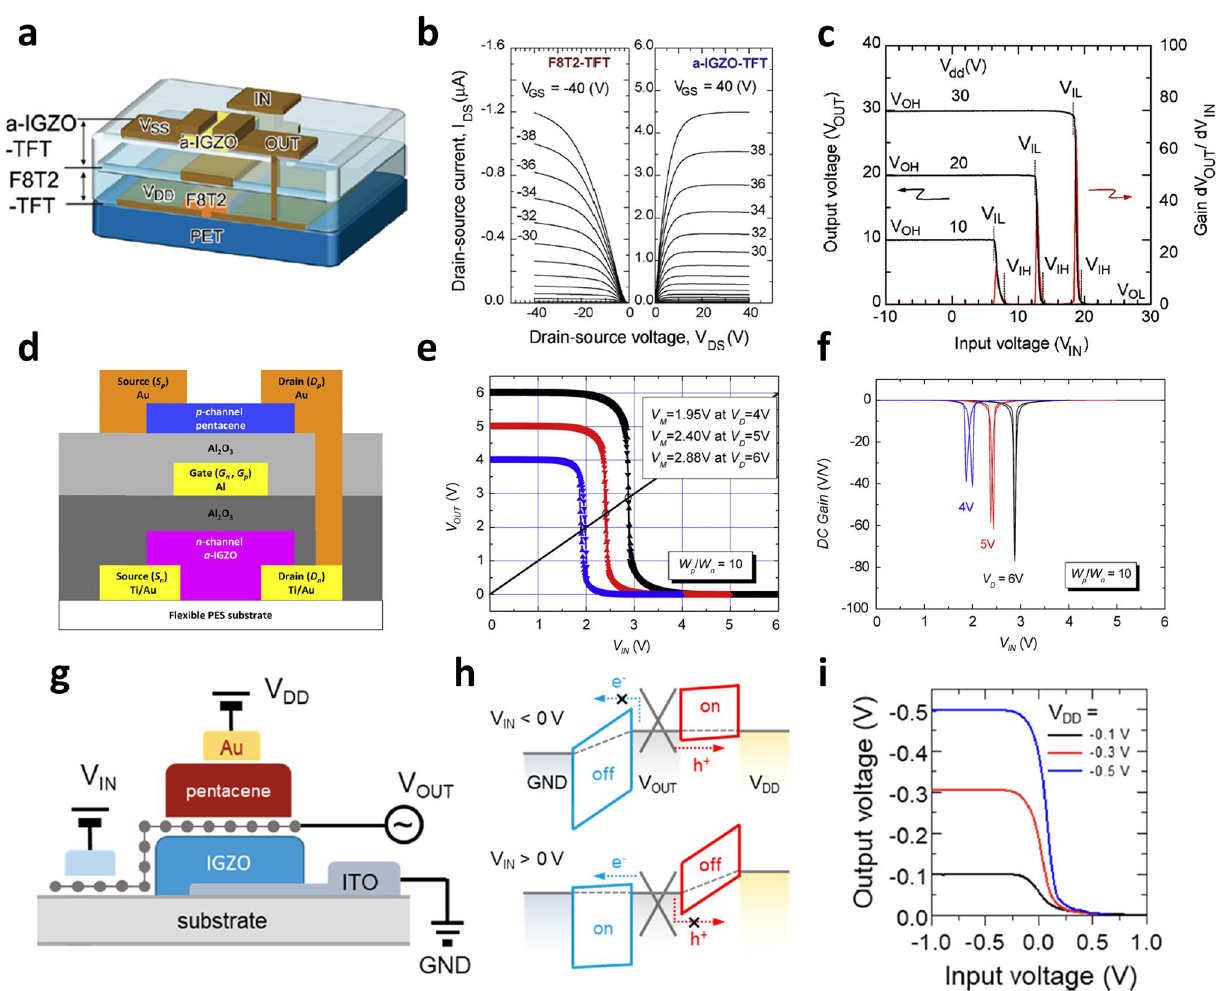
Fig. 6 a Schematic diagram of a vertically stacked inverter with a structure in which the F8T2 TFT and the IGZO TFT share a gate electrode. b Output curves of the F8T2 TFT and IGZO TFT. c Voltage transfer characteristics of the vertically stacked organic-metal oxide hybrid inverter [90]. Copyright © 2010, AIP Publishing. d Schematic diagram of the vertically stacked organic-metal oxide hybrid inverter composed of IGZO TFT and pentacene TFT. e, f Voltage transfer characteristics and DC gain profiles of IGZO-pentacene vertically stacked inverters at V DD of 4, 5, and 6 V [91]. Copyright © 2011, Elsevier. g Schematic device structure of a vertically stacked complementary inverter based on vertical Schottky barrier transistors composed of pentacene and IGZO. h, i Realization of inverter characteristics by controlling the Schottky barrier of junction between pentacene and graphene, IGZO and graphene through Fermi level modulation of graphene [15]. Copyright © 2019, American Chemical